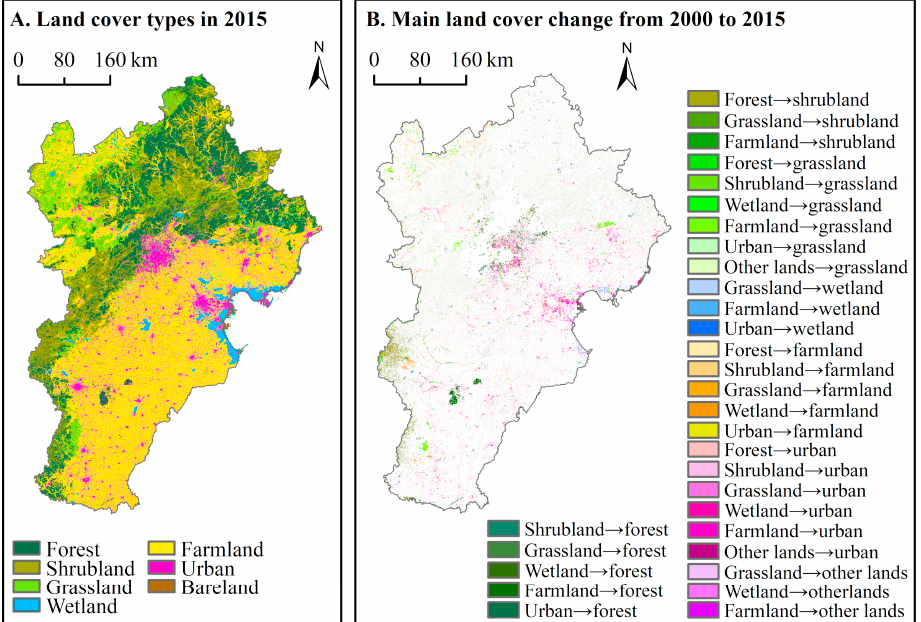
Figure 5. Distribution and changes in ecosystems in the Beijing–Tianjin–Hebei urban agglomeration: ( A ) spatial distribution of ecosystems in the Beijing–Tianjin–Hebei urban agglomeration in 2015; ( B ) spatial distribution of ecosystem changes in the Beijing–Tianjin–Hebei urban agglomeration from 2000 to 2015.